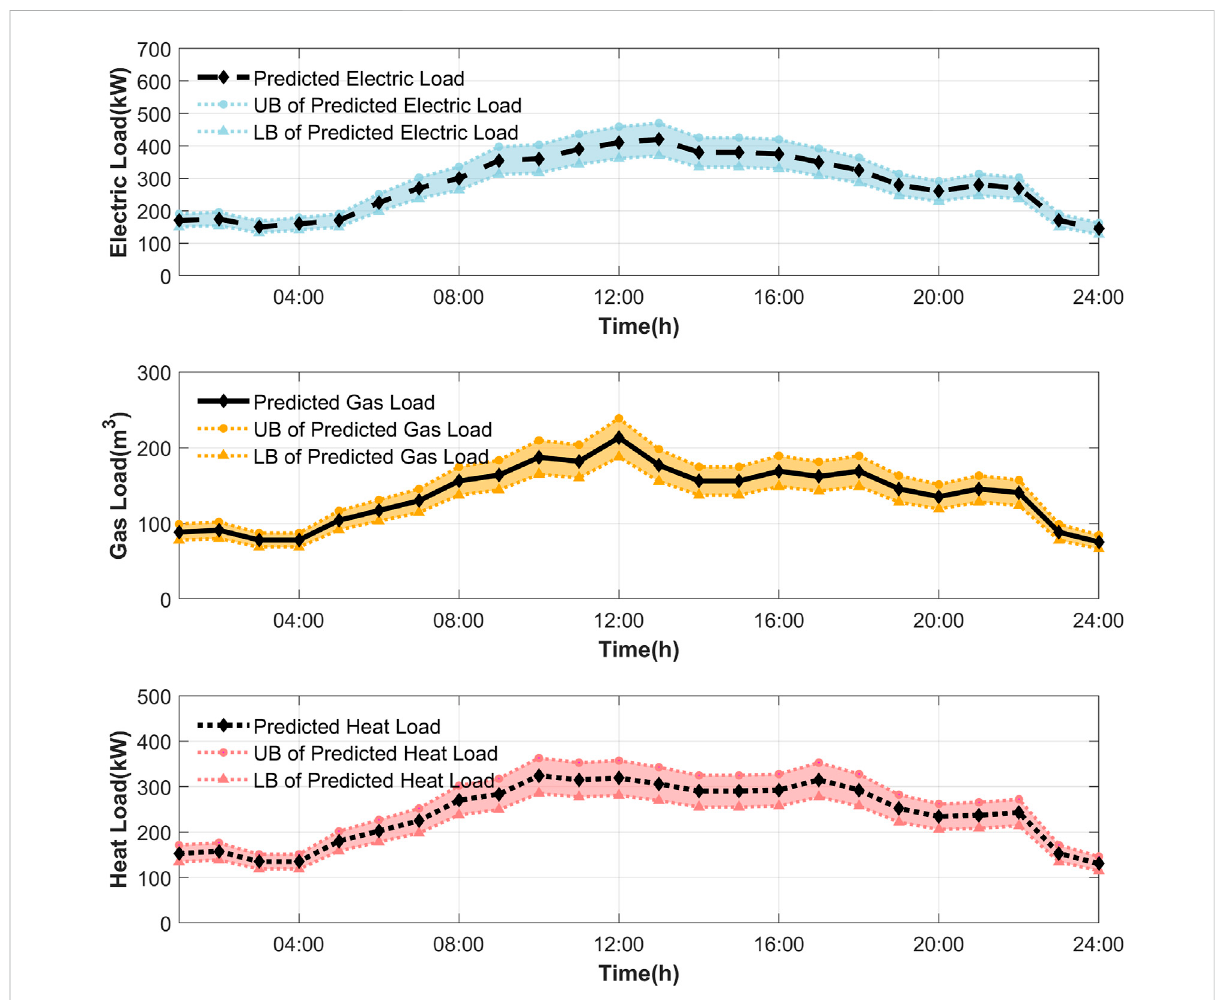
FIGURE 6 MEMG load pro fi les predicted, and uncertainty